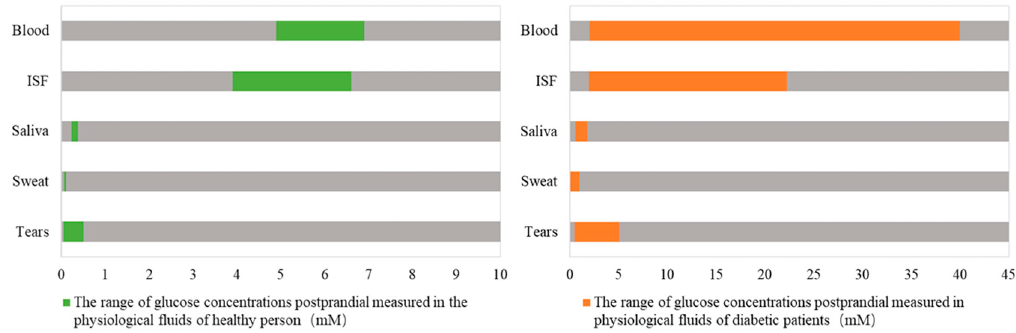
Figure 1. Contrast of glucose concentrations in different physiological fluids between healthy and diabetic people.